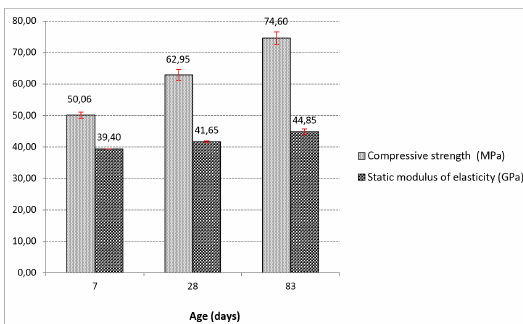
Figure 8. Results of compressive strength and modulus of elasticity of BGP SCC.